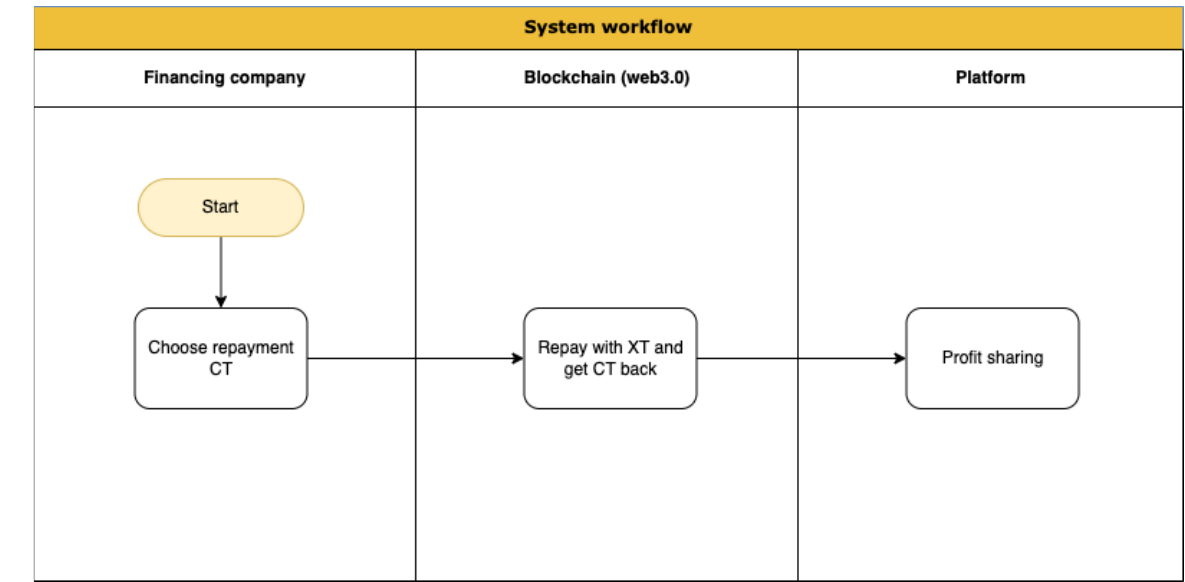
FinTech 2023 , 2 , FOR PEER REVIEW